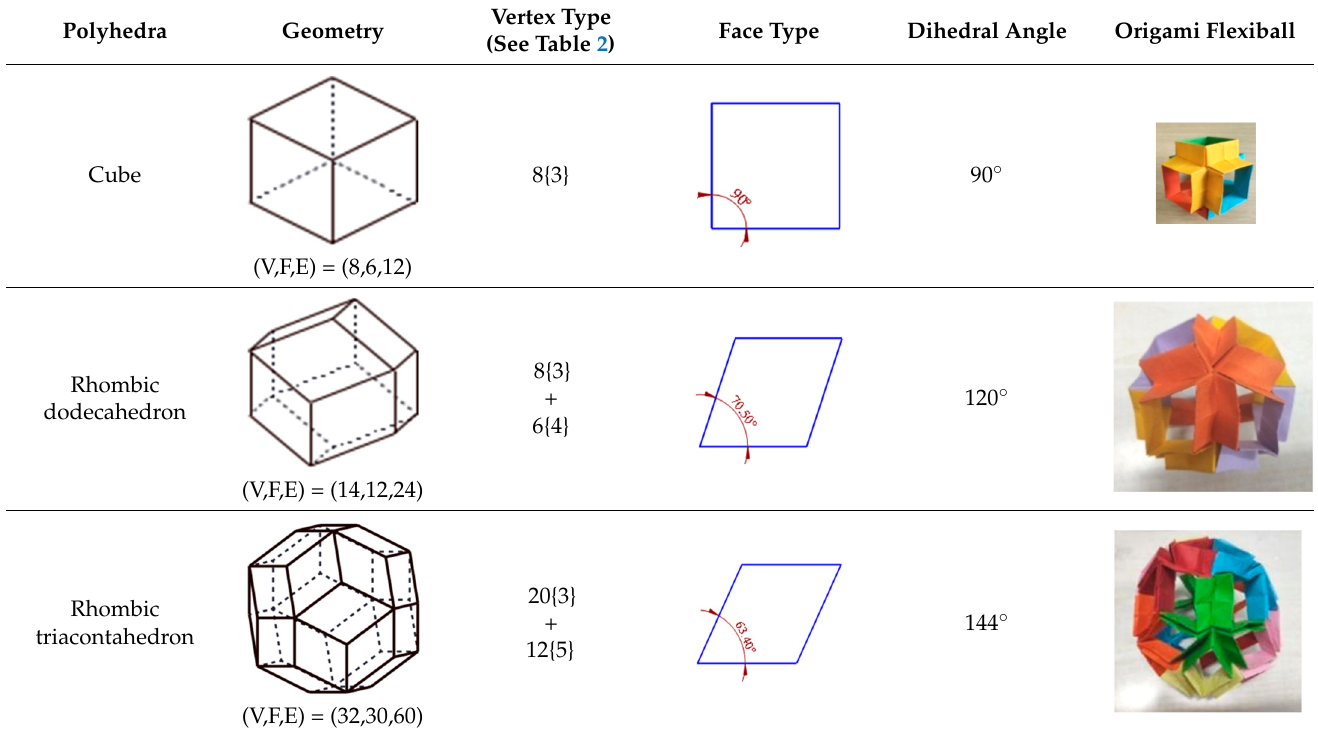
Table 1. Topology and geometries of origami flexiballs.